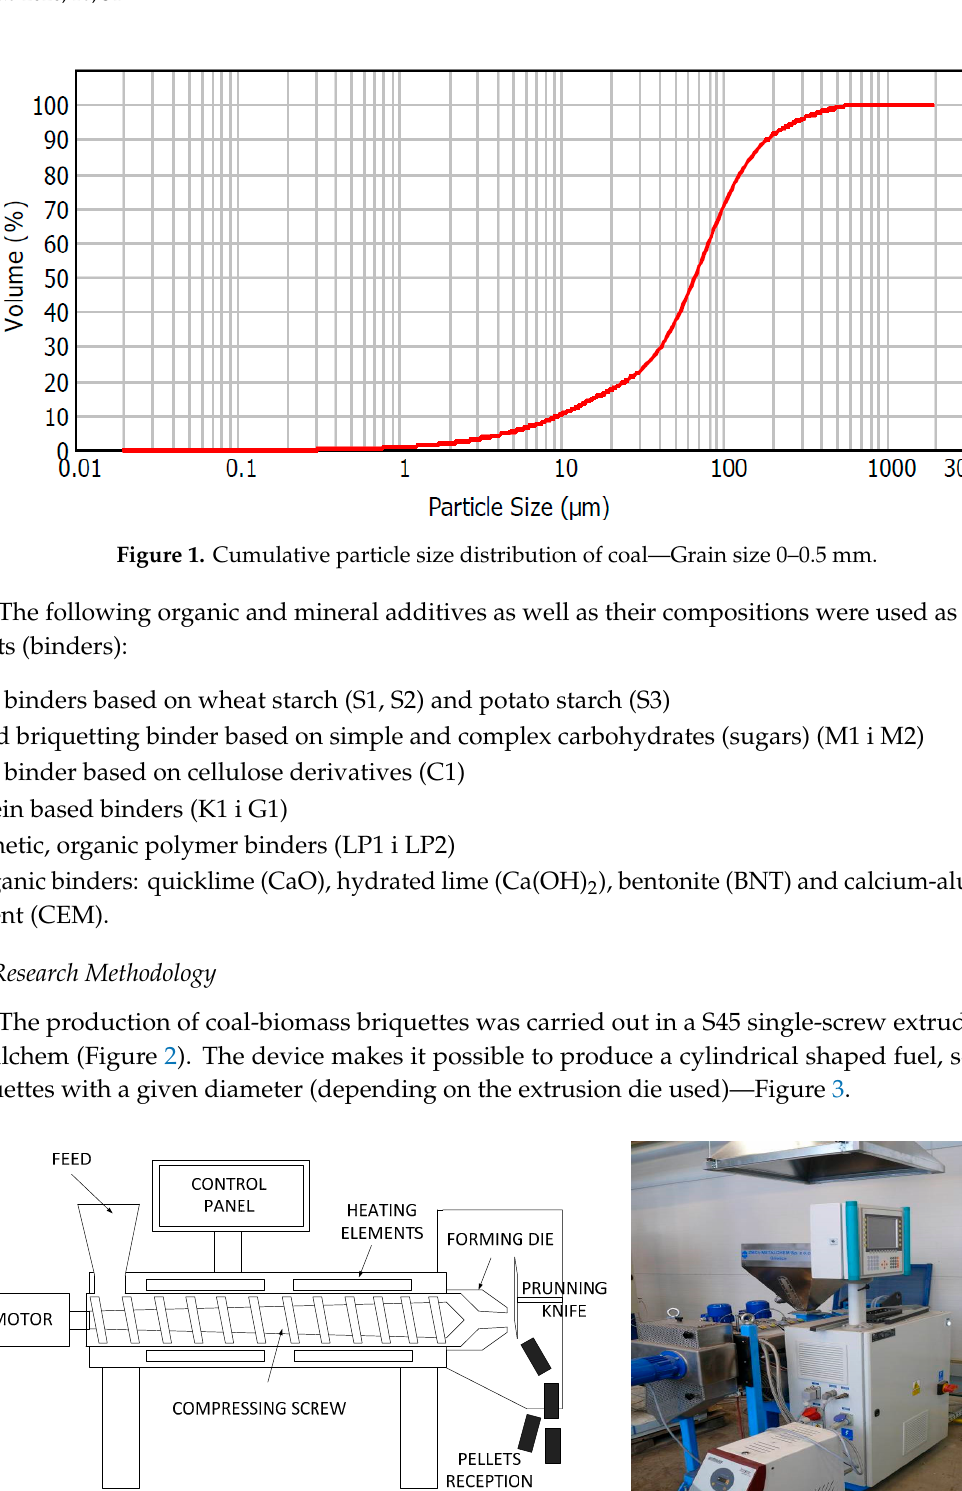
Figure 2. ( a ) Scheme of the single-screw extruder; ( b ) general view of the single-screw extruder.